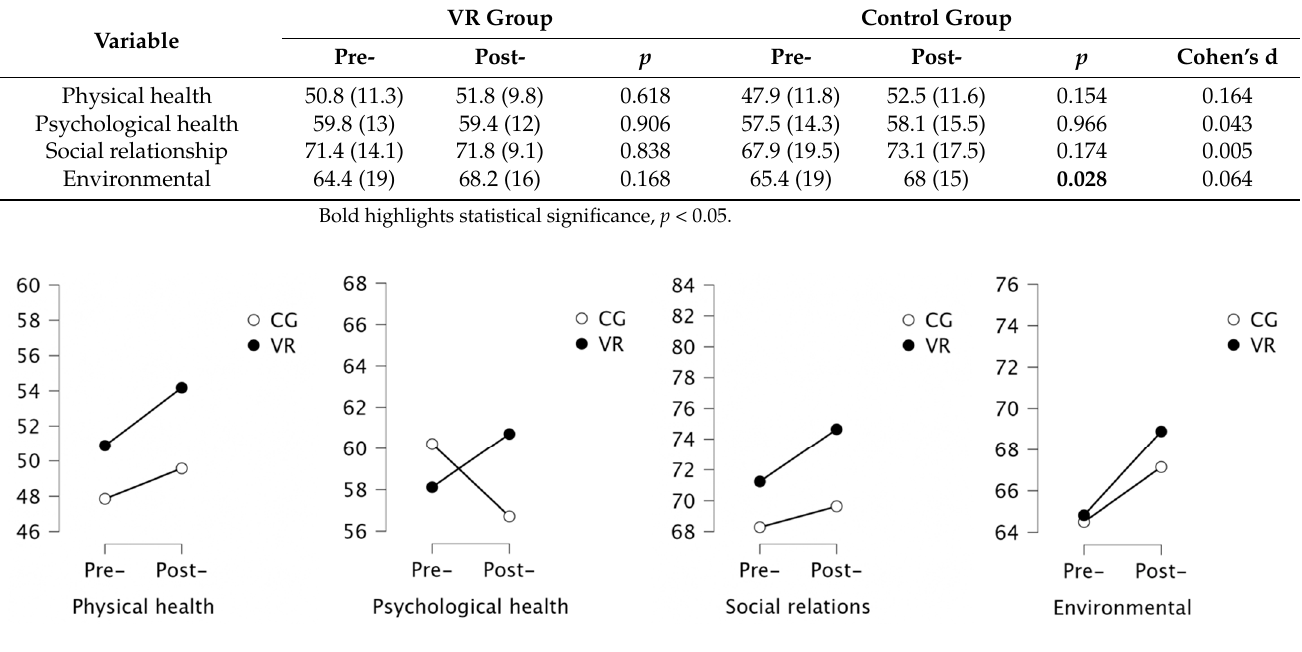
Figure 5. Results of the analysis of Quality of Life.